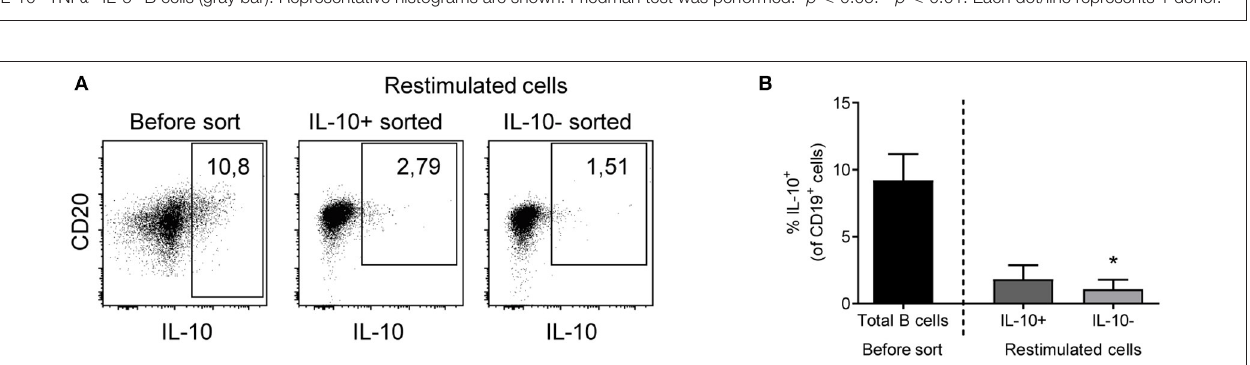
FIGURE 5 | (A–C) Median expression of CD21, CD80, and CD5 on IL-10 + TNF α + IL-6 + (white bar) and IL-10 + TNF α − IL-6 − (gray bar) B cells. (B,C) Frequency of CD80 + and CD5 + B cells within IL-10 + TNF α + IL-6 + and IL-10 + TNF α − IL-6 − B cells. (D–F) Median expression of CD21, CD80, and CD5 on IL-10 + TNF α + IL-6 + (white bar), various cytokine double-positive (IL-10 − TNF α + IL-6 + , IL-10 + TNF α + IL-6 − , IL-10 + TNF α − IL-6 + ; as depicted) and IL-10 − TNF α + IL-6 − (gray bar) and IL-10 − TNF α − IL-6 + B cells (gray bar). (E,F) Frequency of CD80 + and CD5 + B cells within IL-10 + TNF α + IL-6 + (white bar), various cytokine double-positive